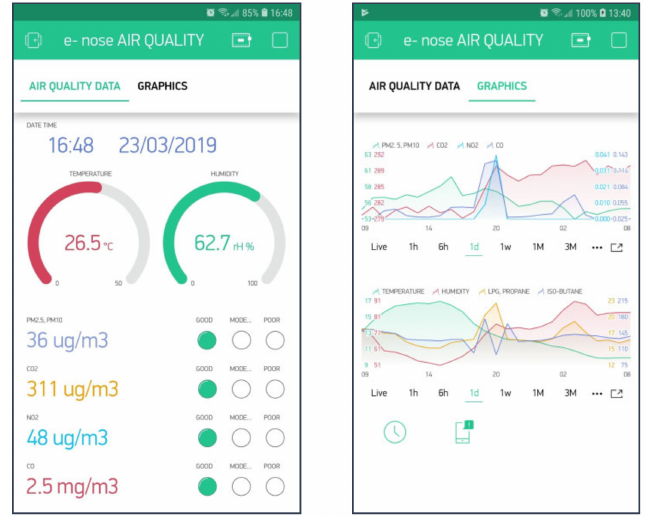
Figure 3. Mobile user interface developed for the e-nose system.